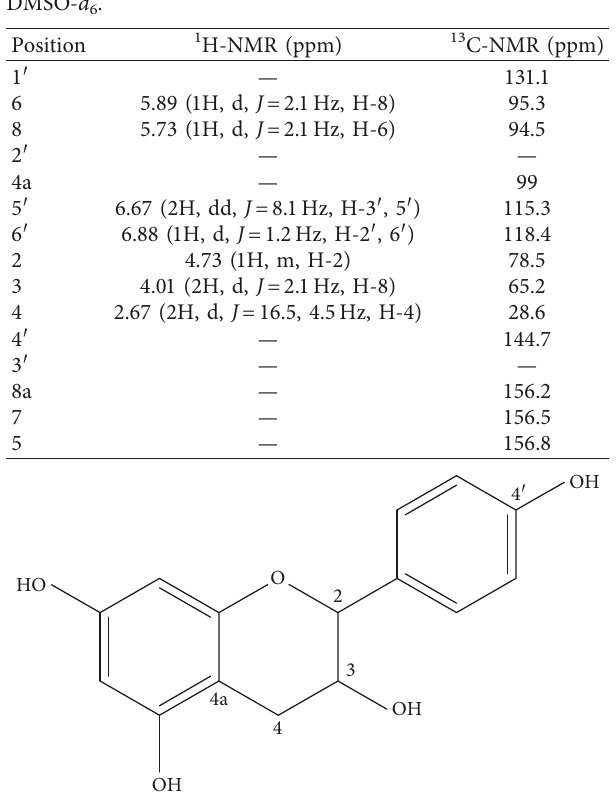
Table 3: 1 H-NMR and 13 C-NMR spectral data of compound 2 in DMSO- d 6 .